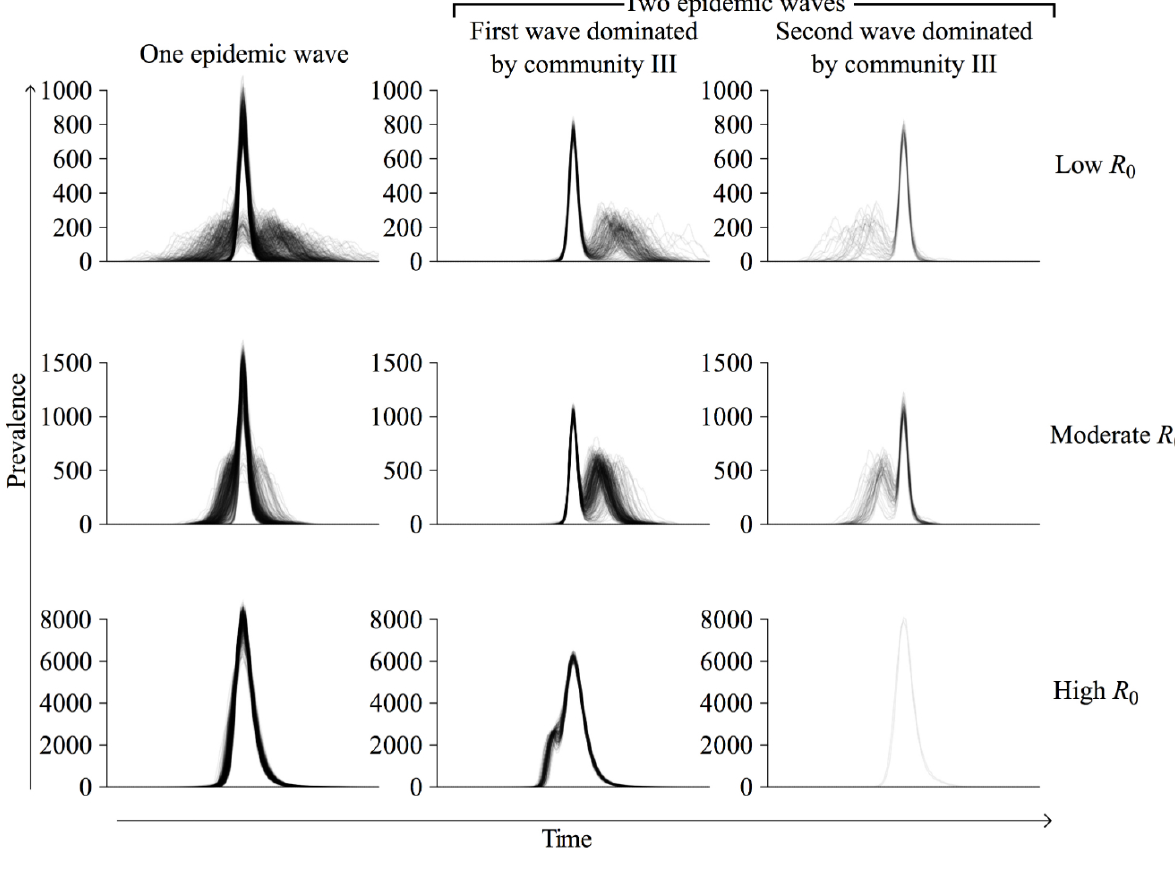
Figure 5. A typical epidemic curve with 2 waves (R 0 =3.7). Community III drove the first wave; communities I and II drove the second